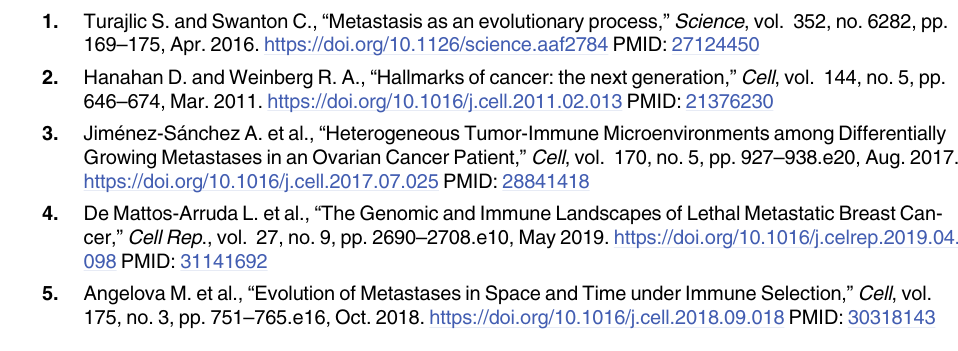
S11 Fig. Adaptive vs Innate expression in CPI treated patients. Scatterplots showing the adaptive immune expression vs. the innate immune expression in each patient for the Mar- iathasan cohort. The points are coloured by their response to immunotherapy. S1 Table. Genes used to define the cell types. A list of the 67 genes used in the gene expres- sion analysis to define the expression of the cell types used for further analyses [24]. S2 Table. Result of multivariable Cox proportional hazard model. Full table of results from the multivariable Cox proportional hazard model from Fig 1A with all